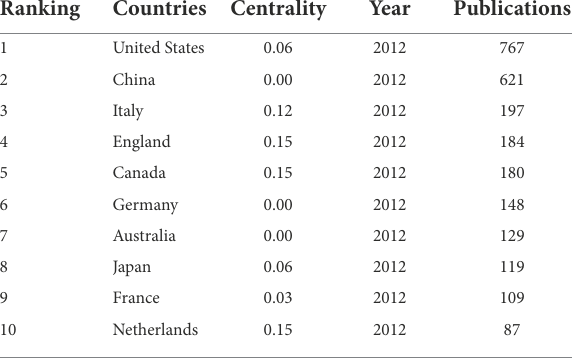
TABLE 1 The ten countries with the most publications.